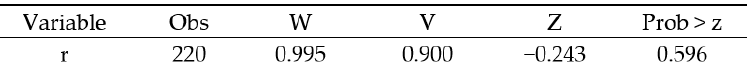
Figure 2. The results of multiple linear regression for the 1st model, including whole analysed macro factors.